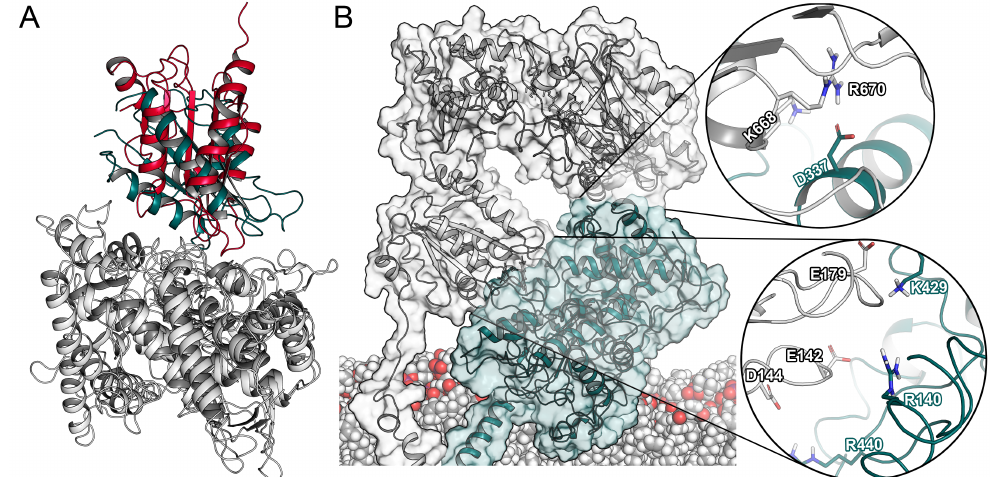
Figure 4. Protein–protein interactions in the CPR–CYP2D6 complex. ( A ) Superposition of CPR– CYP2D6 complex and CYP BM3 (PDB ID: 1BVY). ( B ) Complex of the CPR and CYP2D6 with spotlight on the interaction